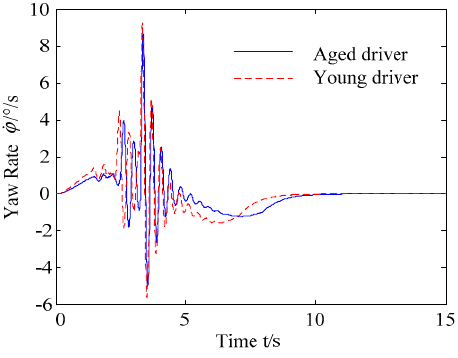
Figure 23. Yaw angle of vehicle p under different handling characteristics.